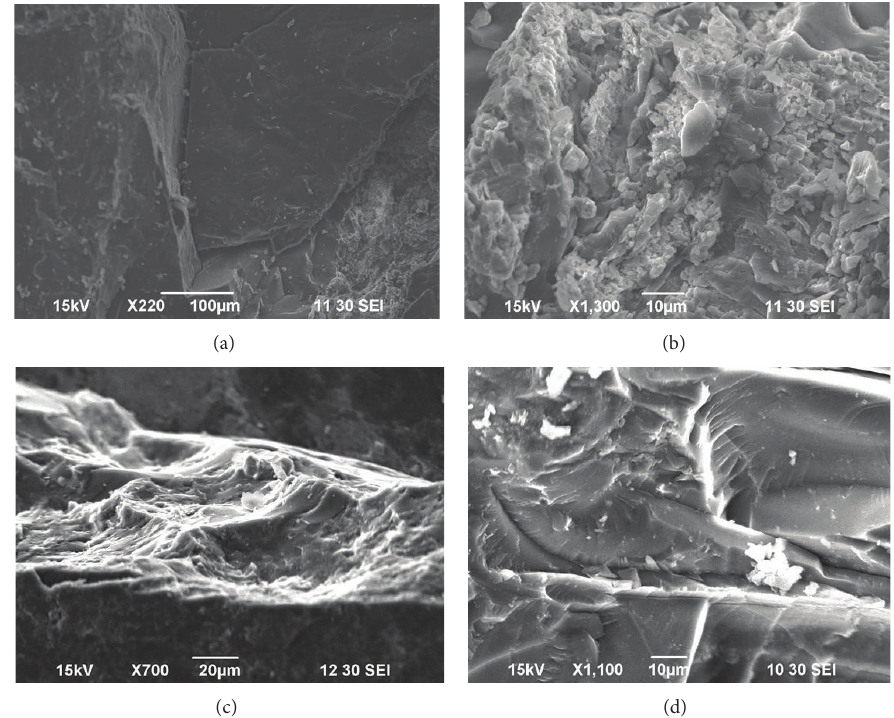
Figure 2: SEM images of deformed coal, (a) weak brittle deformed coal (Y04); (b) strong brittle deformed coal (H12); (c) weak ductile deformed coal (L04); (d) strong ductile deformed coal (H09).